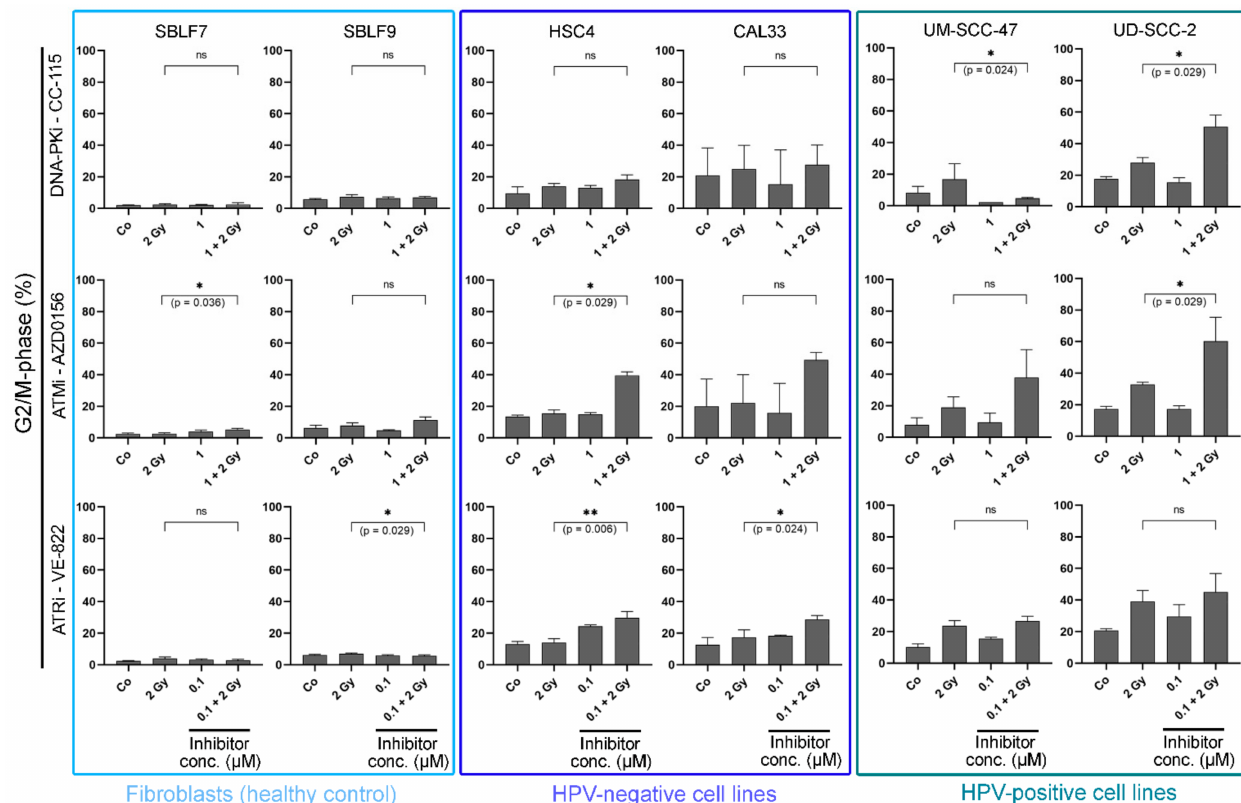
Figure 3. Cell cycle analysis. Cells are grouped into normal donor cells (SBLF7, SBLF9) and HPV-negative (HSC4, CAL33), and HPV-positive (UM SCC 47, UD SCC 2) HNSCC cell lines. The graphs show the proportion of cells in the G2/M phase of the cell cycle and the alteration of G2/M phase under treatment. Cells were either untreated or received IR, KI, or a combination of IR and KI. For CC 115 and AZD0156 1 µ M was used, for VE 822 0.1 µ M was used. Each value represents mean ± SD ( n ≥ 3). Significance was determined by two-tailed Mann Whitney U test * p ≤ 0.05 and ** p ≤